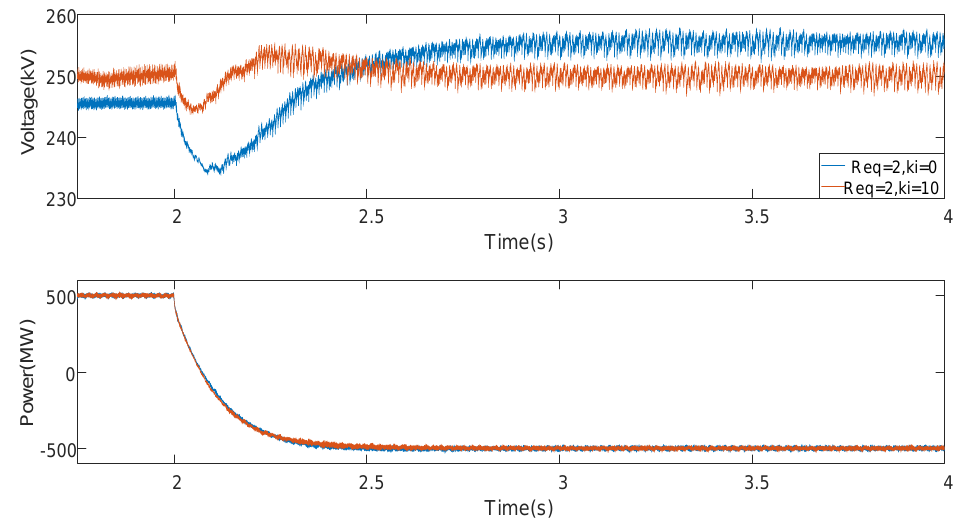
Figure 17. DC-link voltage and active power of the VSC – HVDC system under the proposed control strategy and traditional virtual impedance.